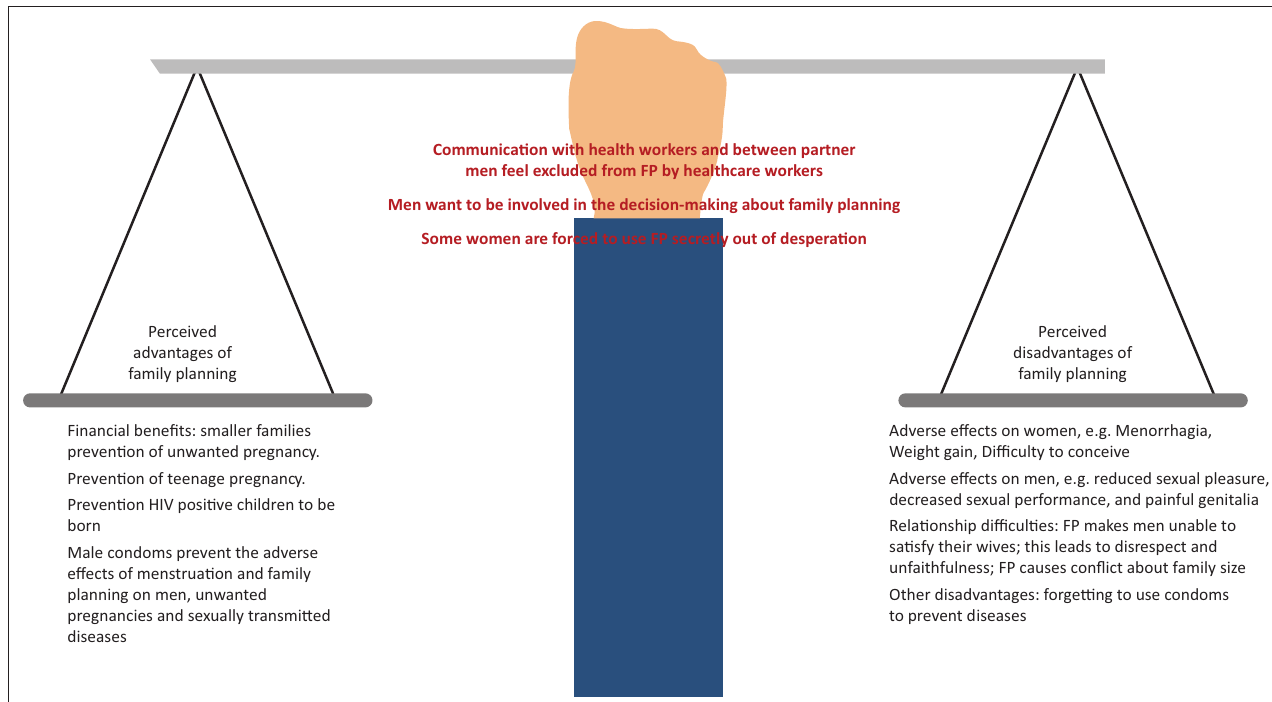
Perceived advantages of family